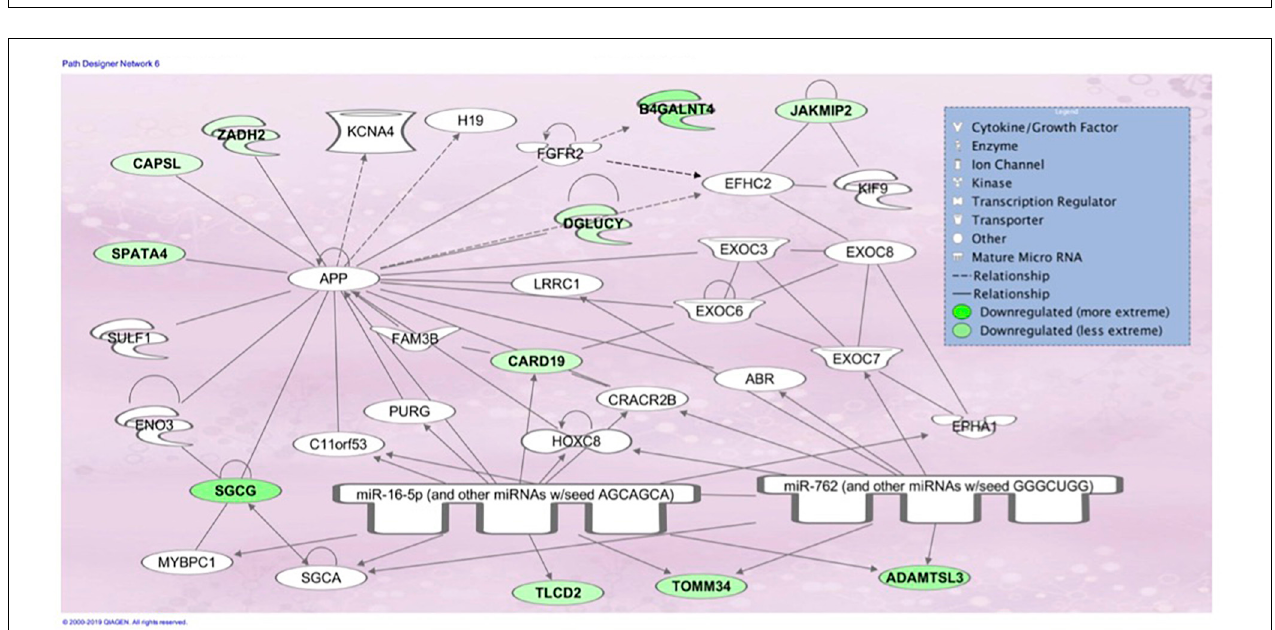
FIGURE 5 | Top associated network function in IPA for the PM transcriptome dataset of birds with normal PM compared to severe/moderate WB: RNA Damage and Repair and Protein Synthesis .